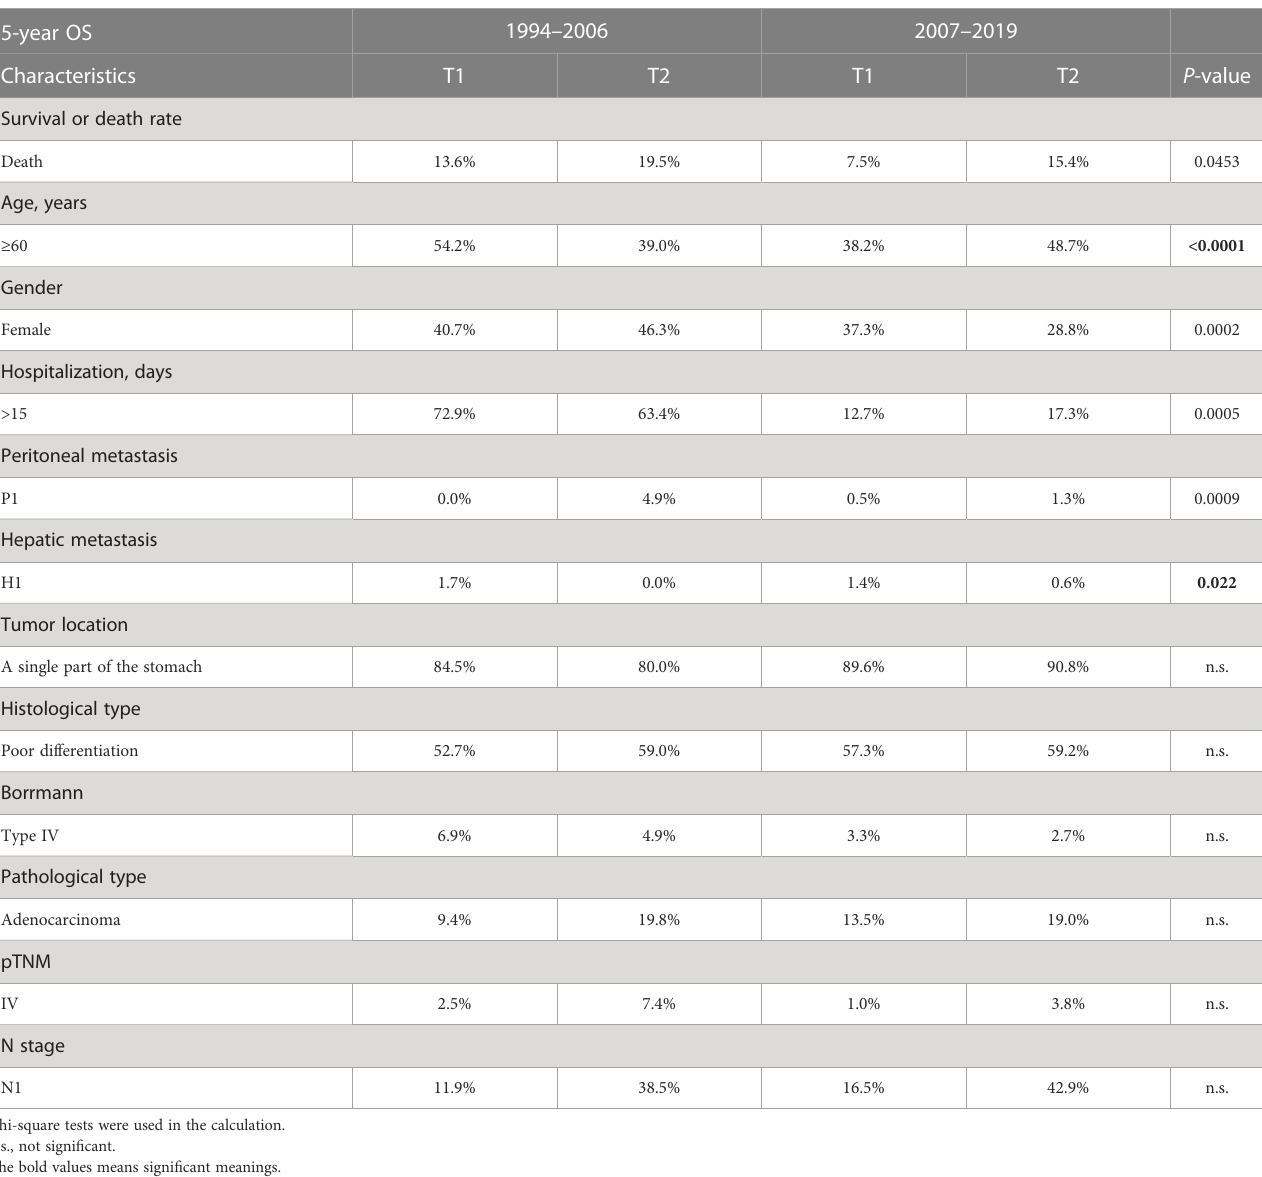
TABLE 6 Trends of hazards of 5-year overall survival (OS) characteristics in the T2